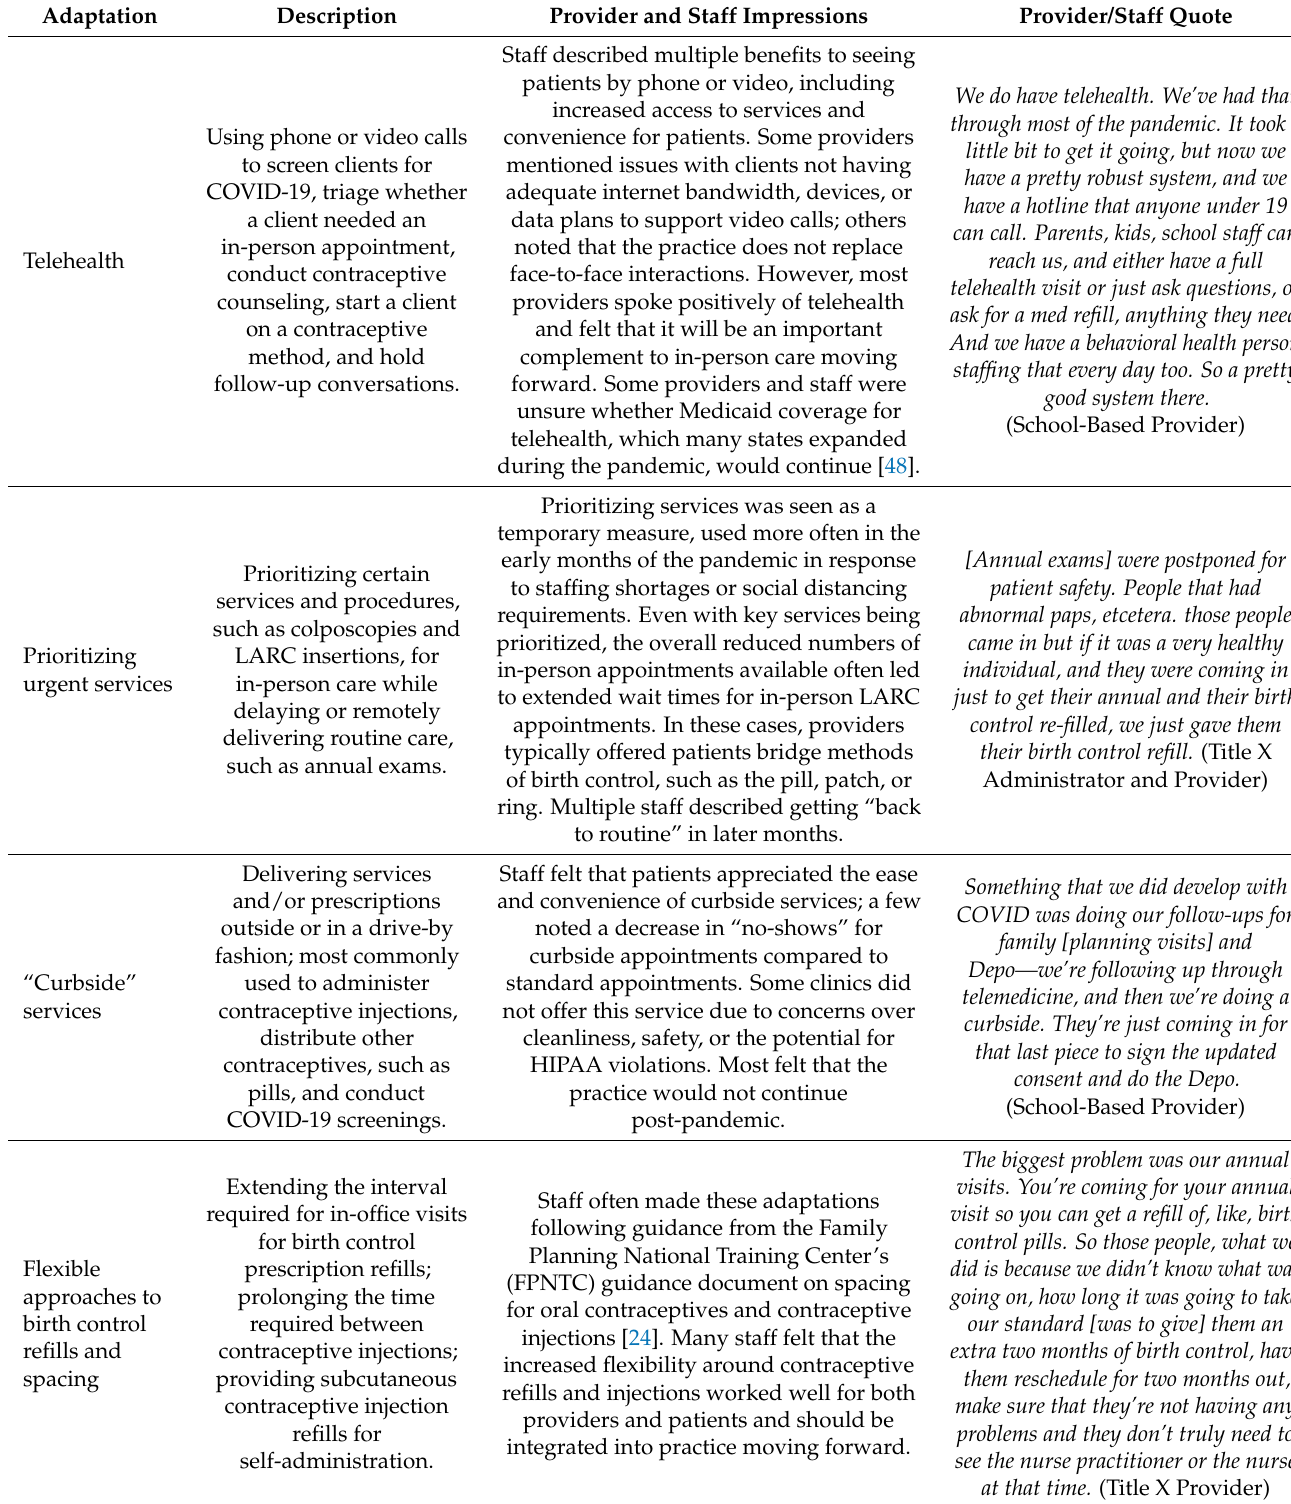
Table 2. Service delivery adaptations described by Title X and school-based